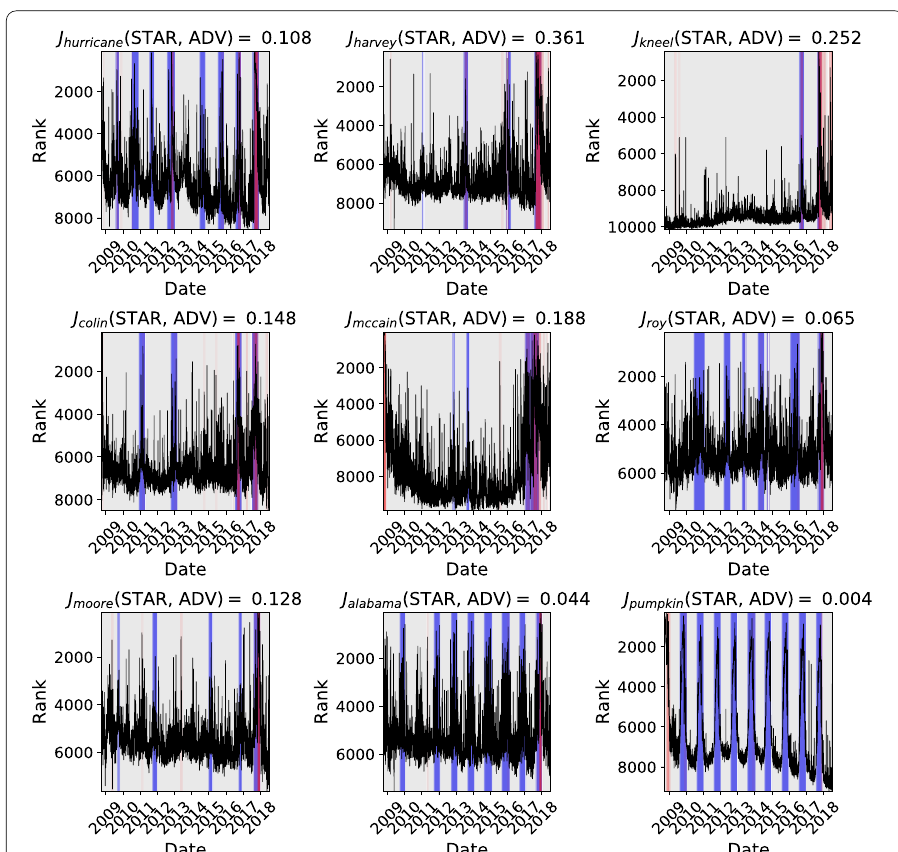
Figure 20 Hurricanes. Comparison of STAR and ADV indicator windows for some words surrounding the autumn of 2017, including Hurricane Harvey, Colin Kaepernick’s kneeling protests, John McCain, the electoral campaign of Roy Moore in the U.S. state of Alabama, and pumpkins (a traditional gourd symbolic of autumn in the